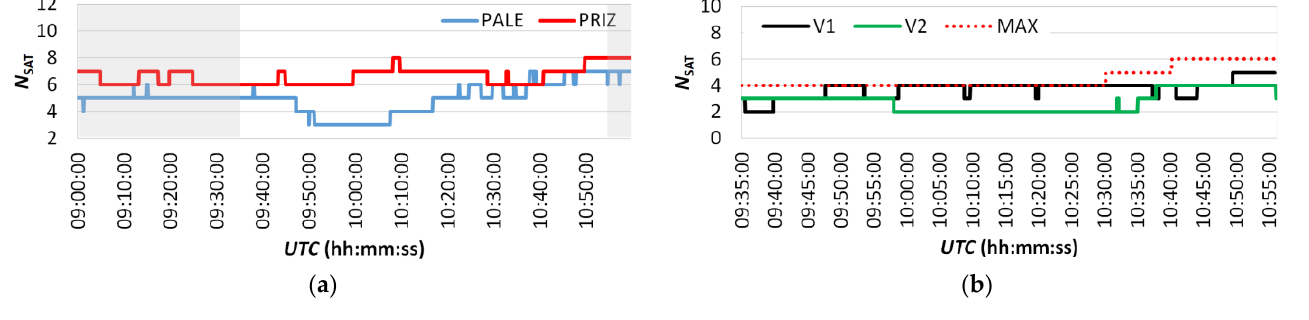
Figure 5. Number of GLONASS satellites: ( a ) CORS PALE and PRIZ (blue and red lines, respectively); ( b ) V1 and V2 (black and green lines, respectively). Non-overlapping periods between the permanent stations and the landmarks acquisitions are shaded in grey. The maximum number of satellites for the given position, measurement period, and elevation cut-off (dashed red line).